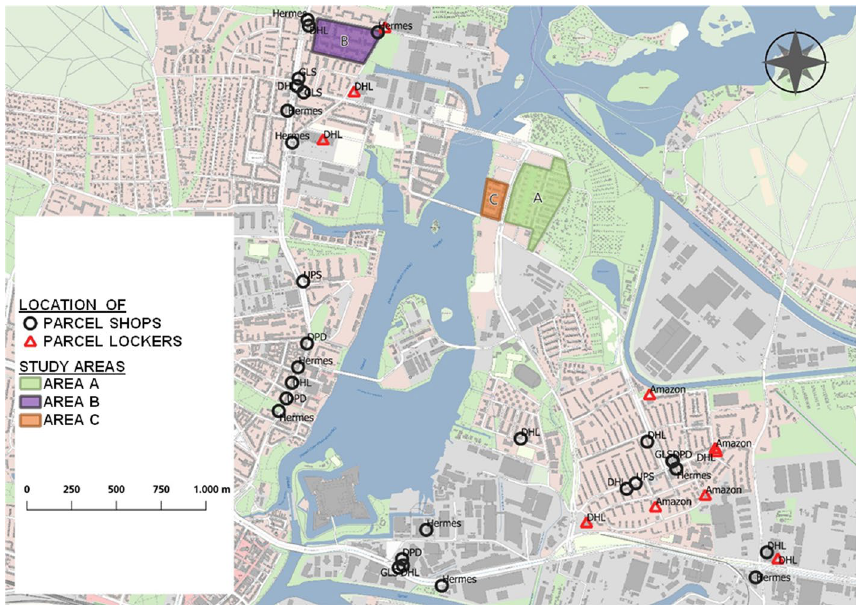
Fig. 3 Location of parcel lockers and parcel shops in the wider vicinity of the study areas. Data source: Geoportal Berlin / WebAtlas Berlin, URL: https:// fbint er. stadt- berlin. de/ fb/ wms/ senst adt/k_ webat lasbe rlin, Data licence Germany – attribution – Version 2.0, URL: www. govda ta. de/ dl- de/